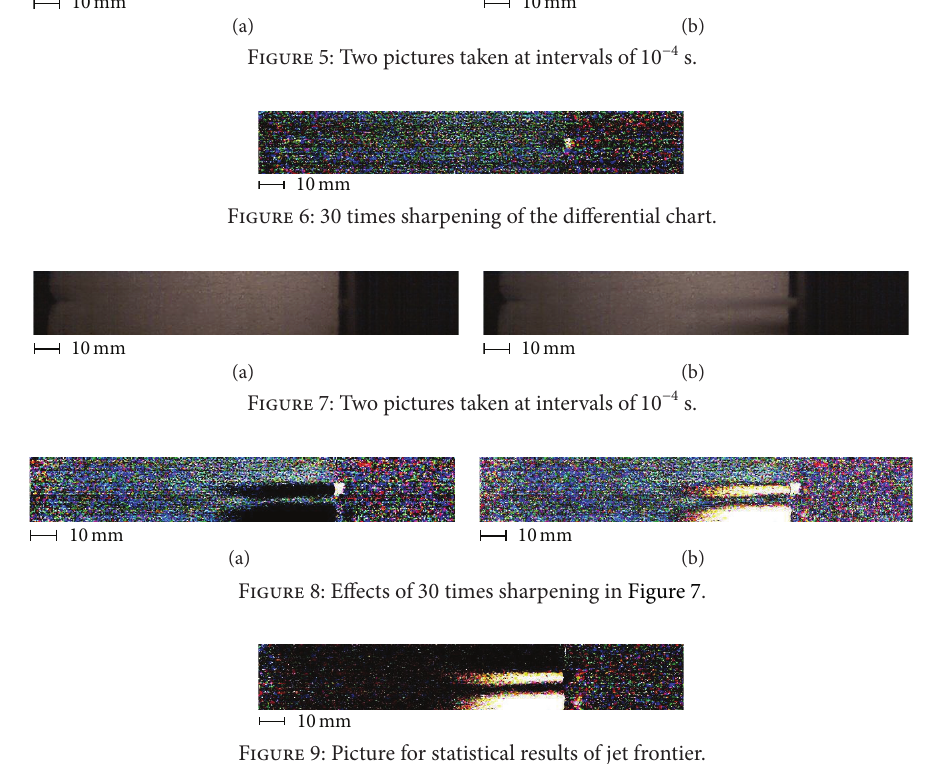
Figure 5: Two pictures taken at intervals of 10 −4 s.